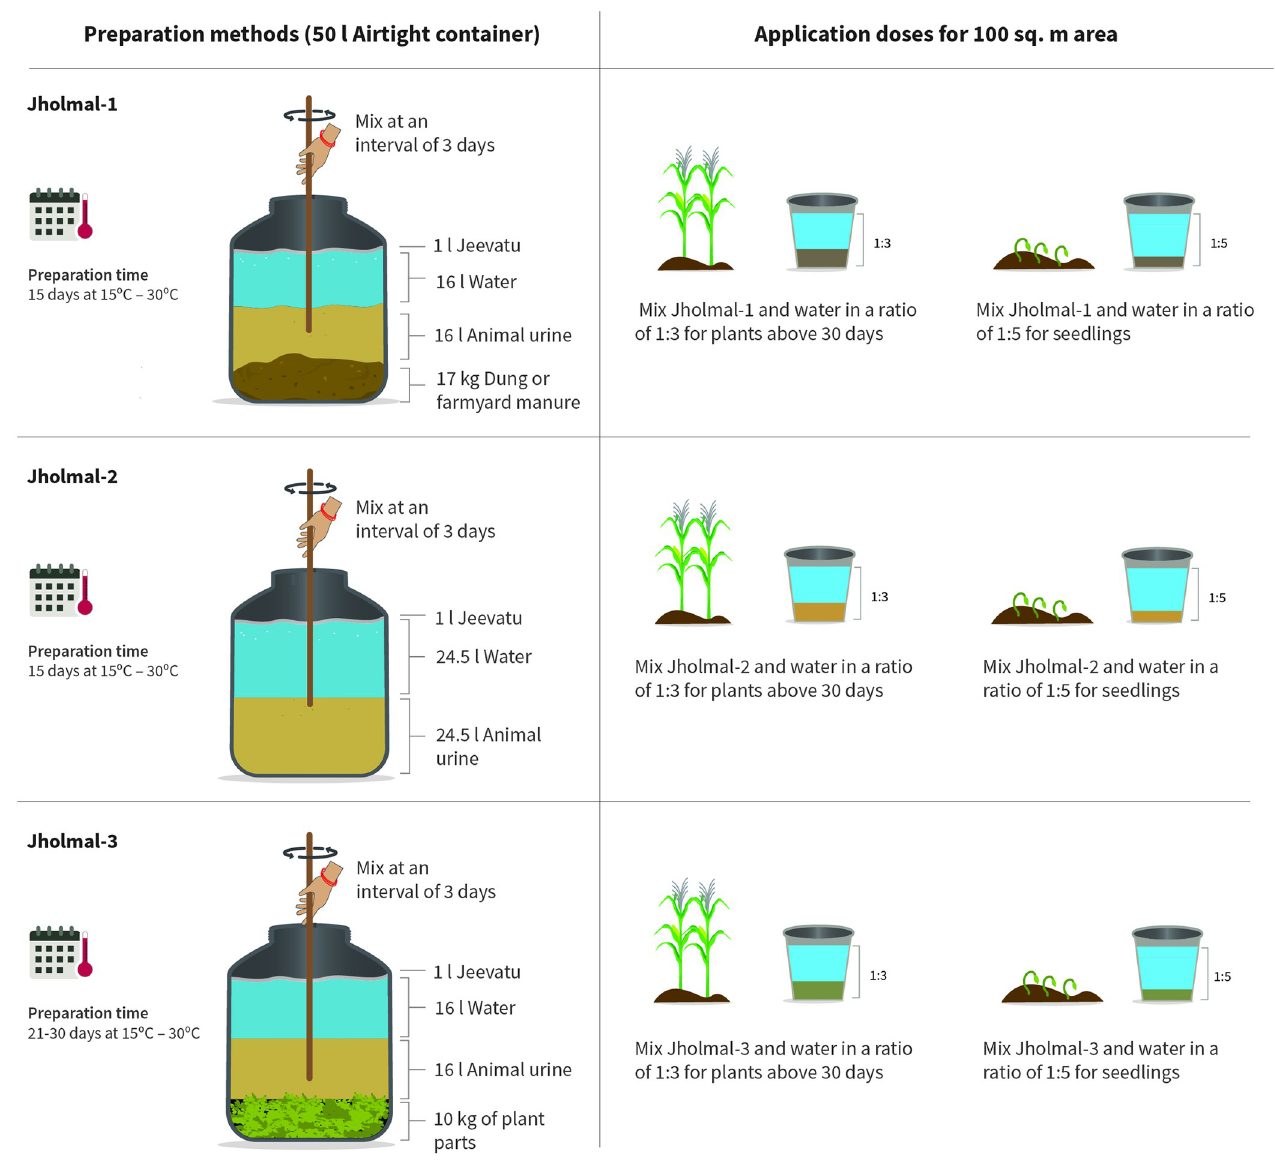
Fig 4. Preparation and application of different jholmal